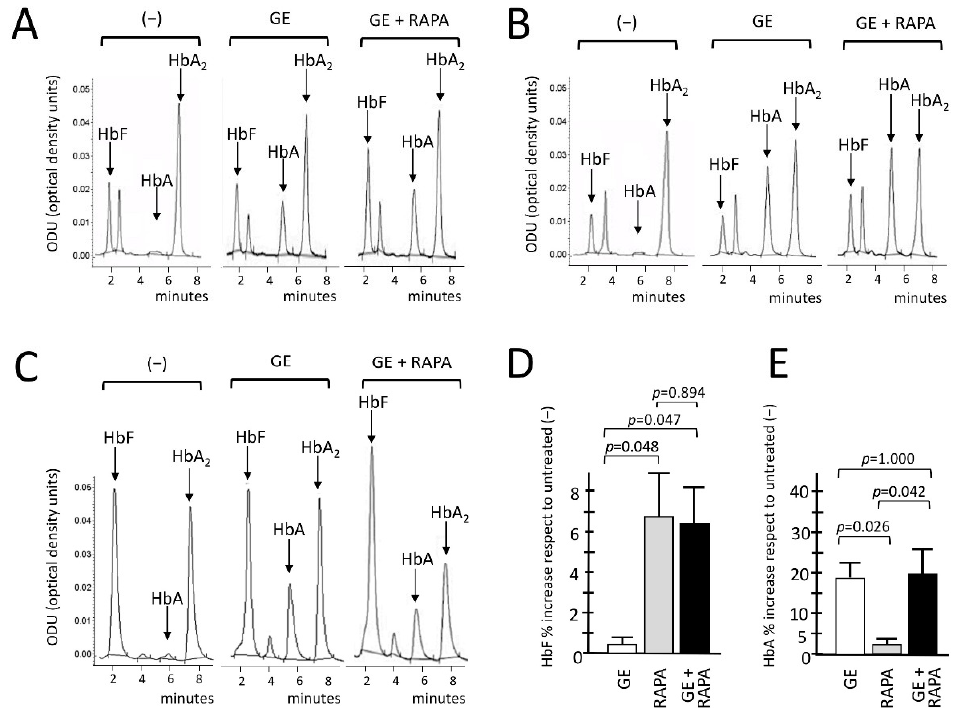
Figure 3. Effects of β 0 39 CRISPR-Cas9 treatment on HbA and HbF hemoglobins, evaluated with HPLC. ( A – C ) Chromatograms related to the HPLC analysis conducted of the protein lysates of the ErPCs cultures derived from three β 0 39-thalassemic patients. For each of them, the expression pattern of hemoglobins in ErPCs untreated ( − ), treated with β 0 39 CRISPR-Cas9 system alone (GE) and with the editing system in combination with rapamycin (GE + RAPA) were analyzed. The average of all patients analyzed for the relative increase in fetal hemoglobin HbF and adult hemoglobin HbA, expressed as a percentage, are shown in panels ( D , E ), respectively. The level of statistical significance is reported as p -value ( p ), significant when p < 0.05.